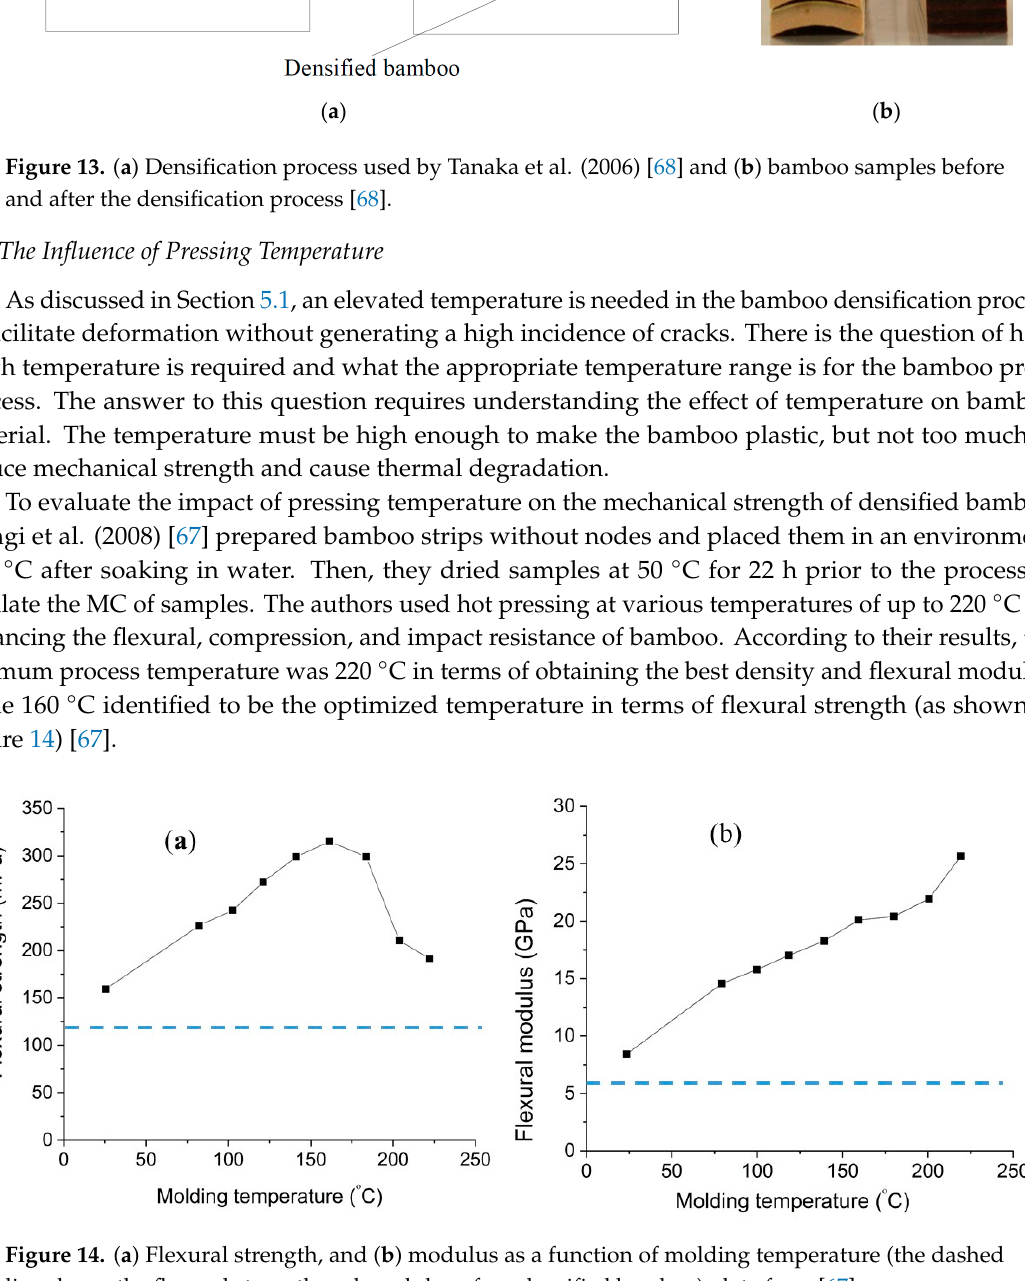
Figure 14. ( a ) Flexural strength, and ( b ) modulus as a function of molding temperature (the dashed line shows the flexural strength and modulus of un-densified bamboo), data from [67].